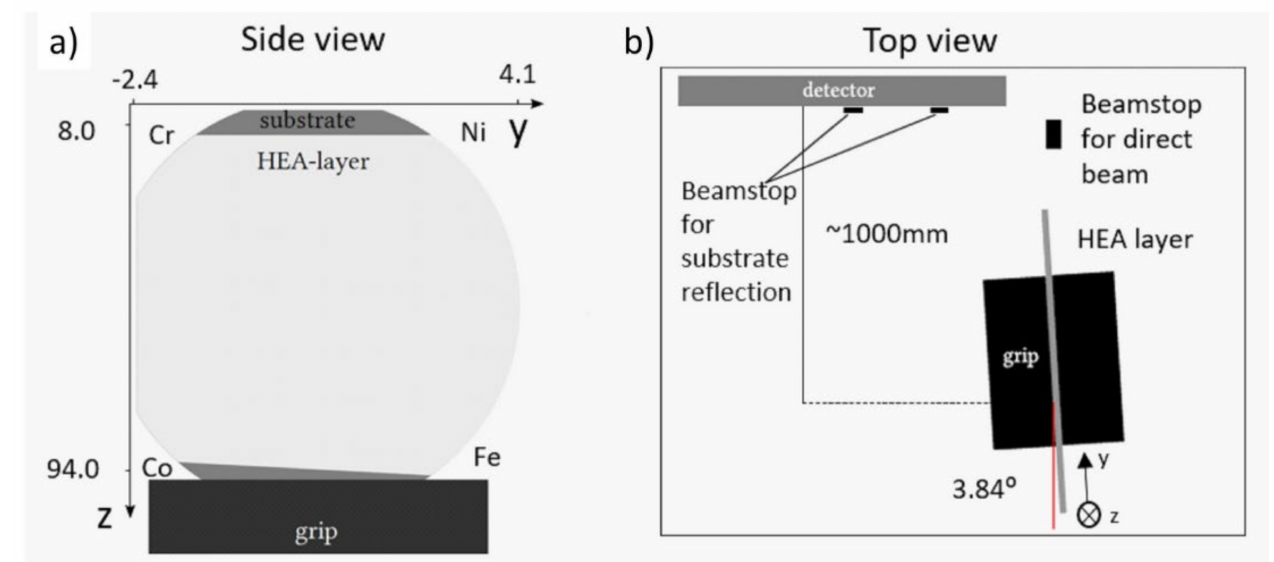
Figure 2. ( a ) Schematic side view of the sample disk showing the coordinate system used in the synchrotron XRD experiments for positioning of the beam on the locations of interest. ( b ) Schematic top view of the XRD